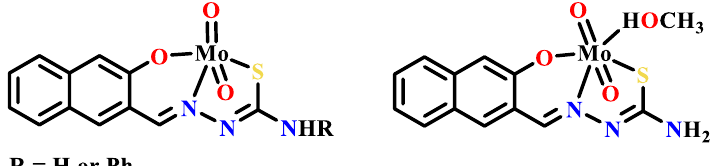
Figure 32. The Mo VI O 2 complexes of naphthylhydrazone with thiourea or phenylthiourea side